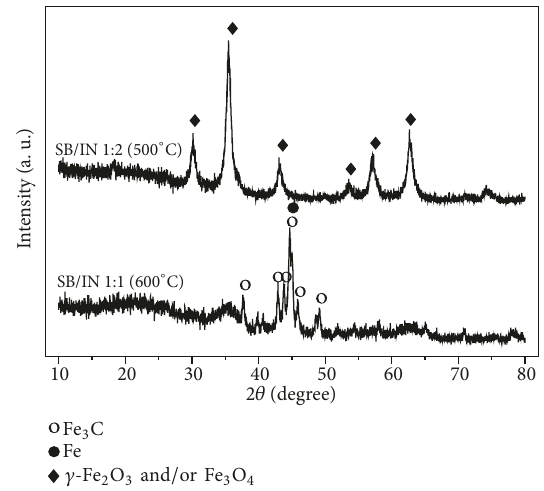
Figure 2: X-raydiffractograms of composites SB/IN 1:2 (500 ∘ C)and SB/IN 1:1 (600 ∘ C).